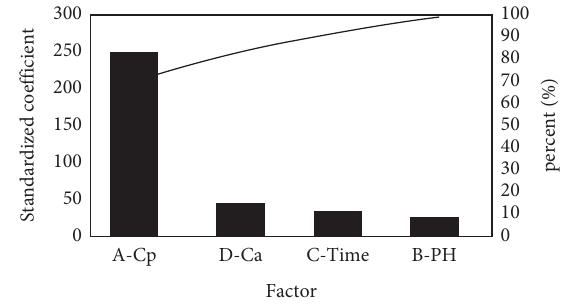
Figure 11: Pareto chart to determine the efect of